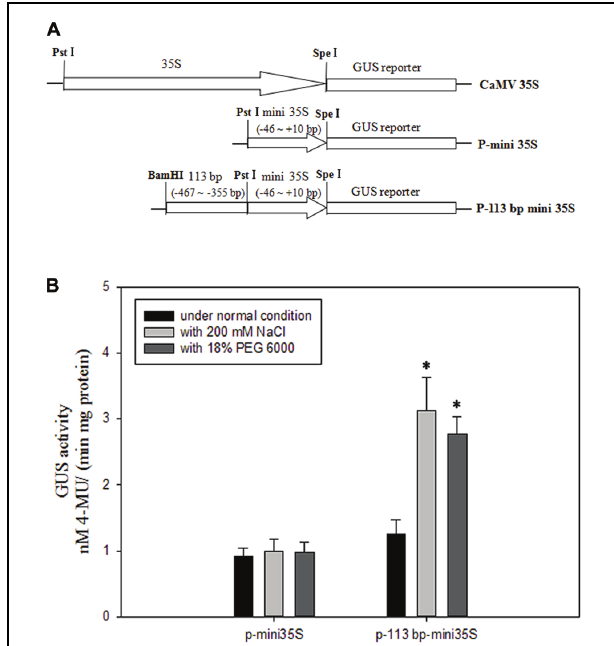
FIGURE 7 | GUS transient assays in tobacco leaves. (A) Fusion constructs used in the transient assay. The CaMV35S represent 35S full length promoter. P-mini 35S represent the mini 35S ( − 46 to + 10 bp) promoter. The test construct P-113 bp mini 35S in which the 113 bp region ( − 467 to − 355 bp) identified in the pZmPIS was fused to the P-mini 35S promoter to drive the GUS expression. (B) GUS enzymatic activity resulting from the transiently transformed tobacco leaves with constructs P-mini 35S and P-113 bp mini 35S under both normal and 200 mM NaCl or 18% (w/v) PEG 6000 treatment for 24 h. Results are mean ± standard deviation from three experiments ( n = 15). The asterisk indicates a significant difference at P <